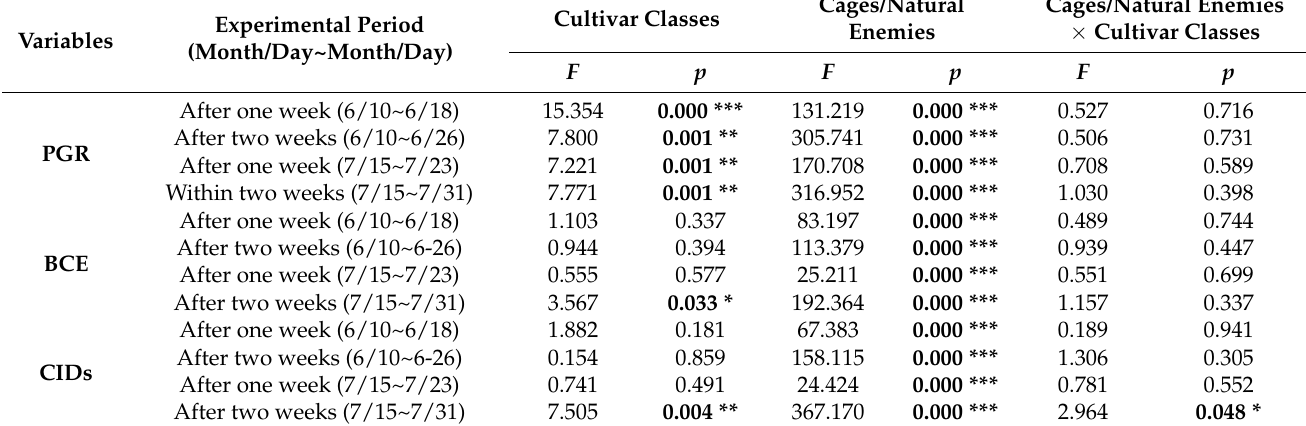
Table 3. F-values and significance levels of the efficacy of control by predators and parasitoids of the pea aphid, Acyrthosiphon pisum , on alfalfa cultivar classes in a field experiment in Ningxia Province, China, in